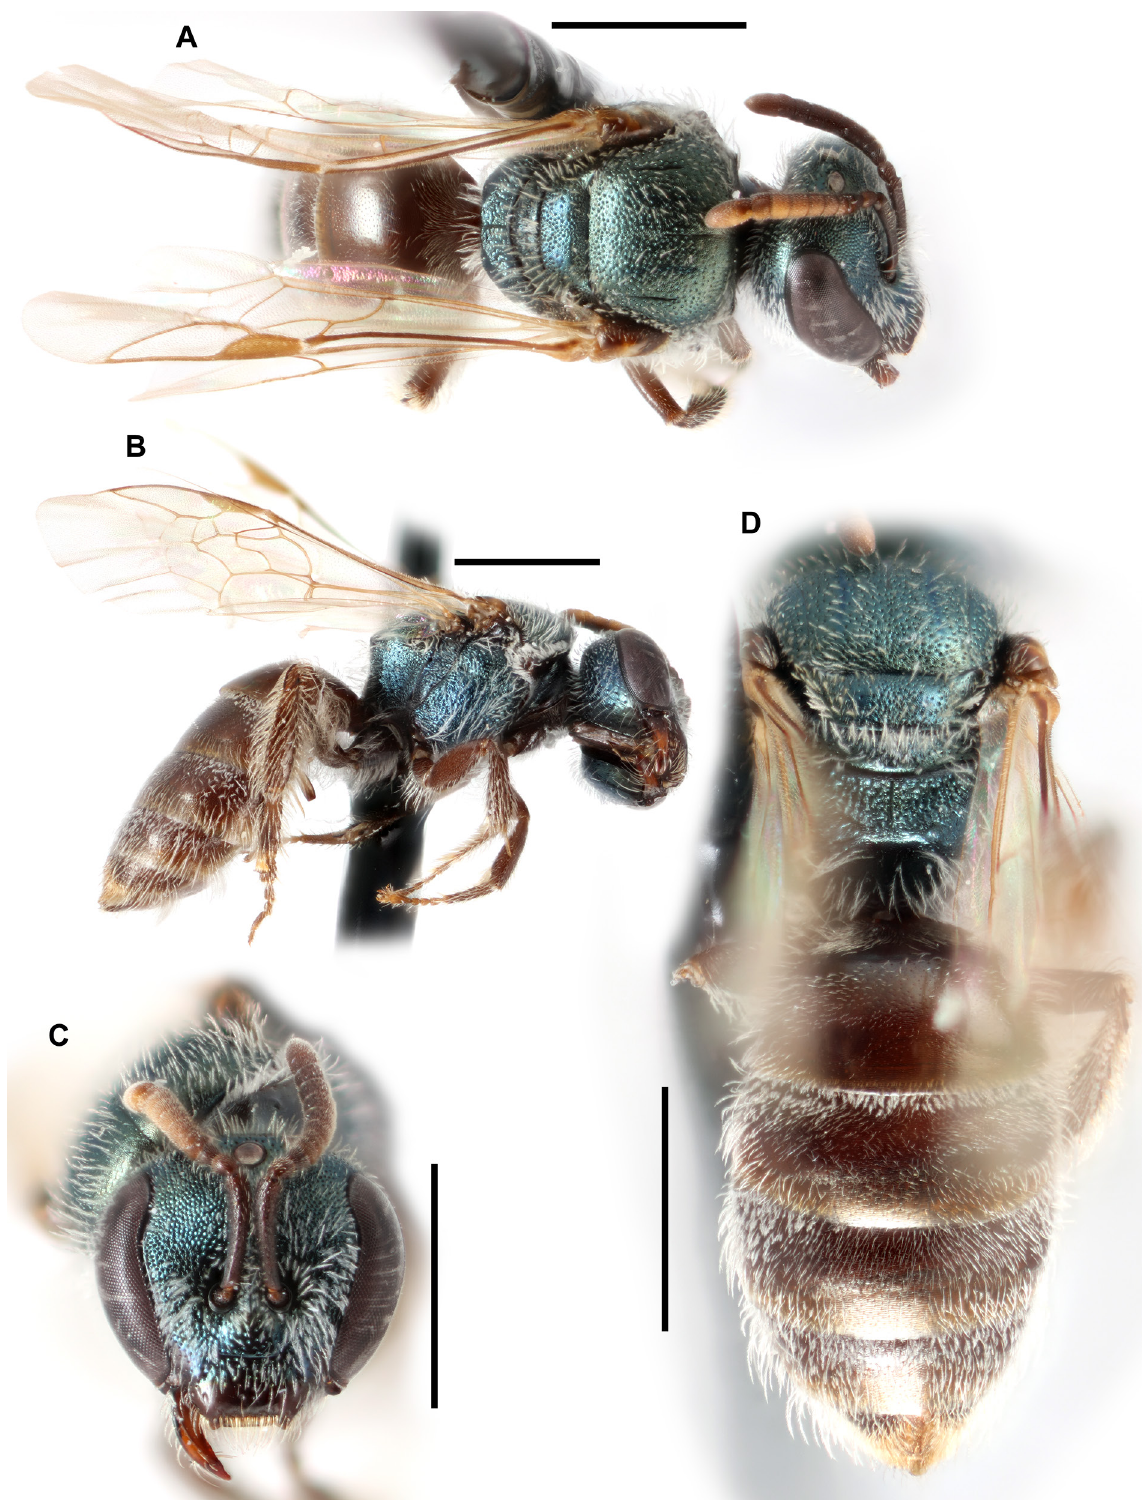
Fig. 48. Lasioglossum ( D .) profundum sp. nov., ♀, holotype (BBSL USGS-DRO 009757). A . Dorsal habitus. B . Lateral habitus. C . Face. D . Metasoma and propodeum. Scale bars = 1